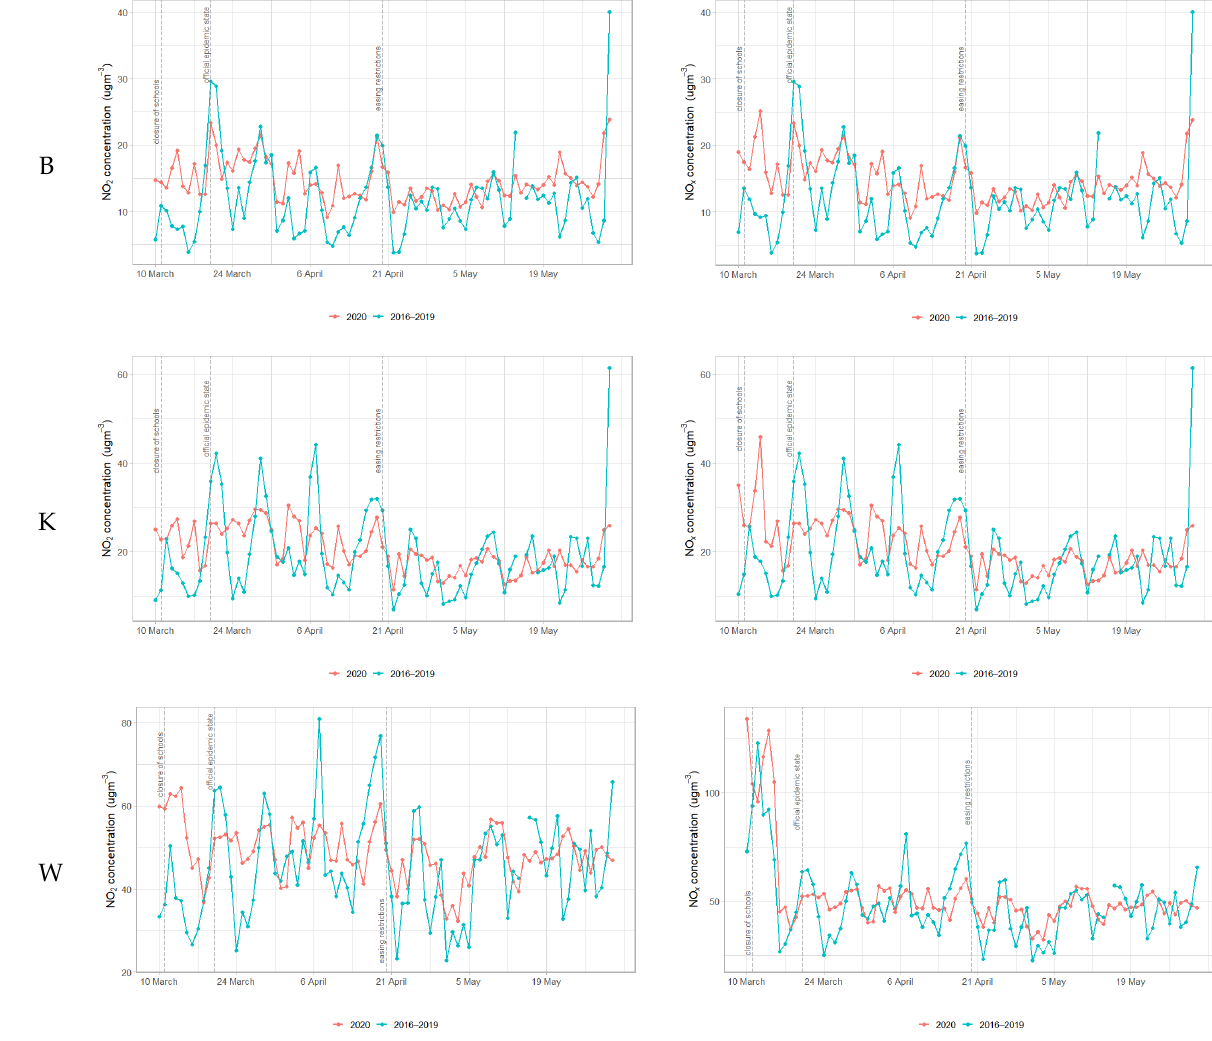
Figure 9. Average daily values of NO 2 and NO x concentrations at three research stations—B and K background and W traffic.